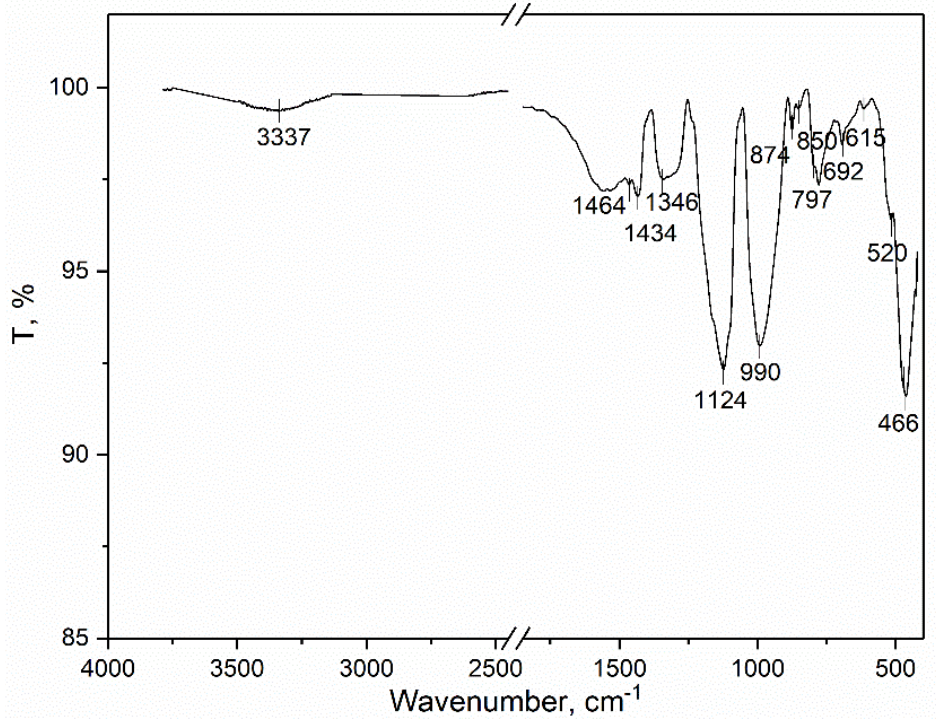
Figure 8. FTIR spectrum of the hardened mortar sample P20-M. Other spectral bands at 990, 850, and 520 cm − 1 are characteristic of the calcium silicate- oxide (Ca 2 SiO 4 ) [33]. As it may be seen from the spectrum of the hardened mortar sample, only spectral bands of the main constituents detected by the XRD are visible. The spectral bands of the new functional groups, as well as bands of other constituents, are not visible which may be explained with overlapping spectral bands or what may be an indication that new phases are not formed.